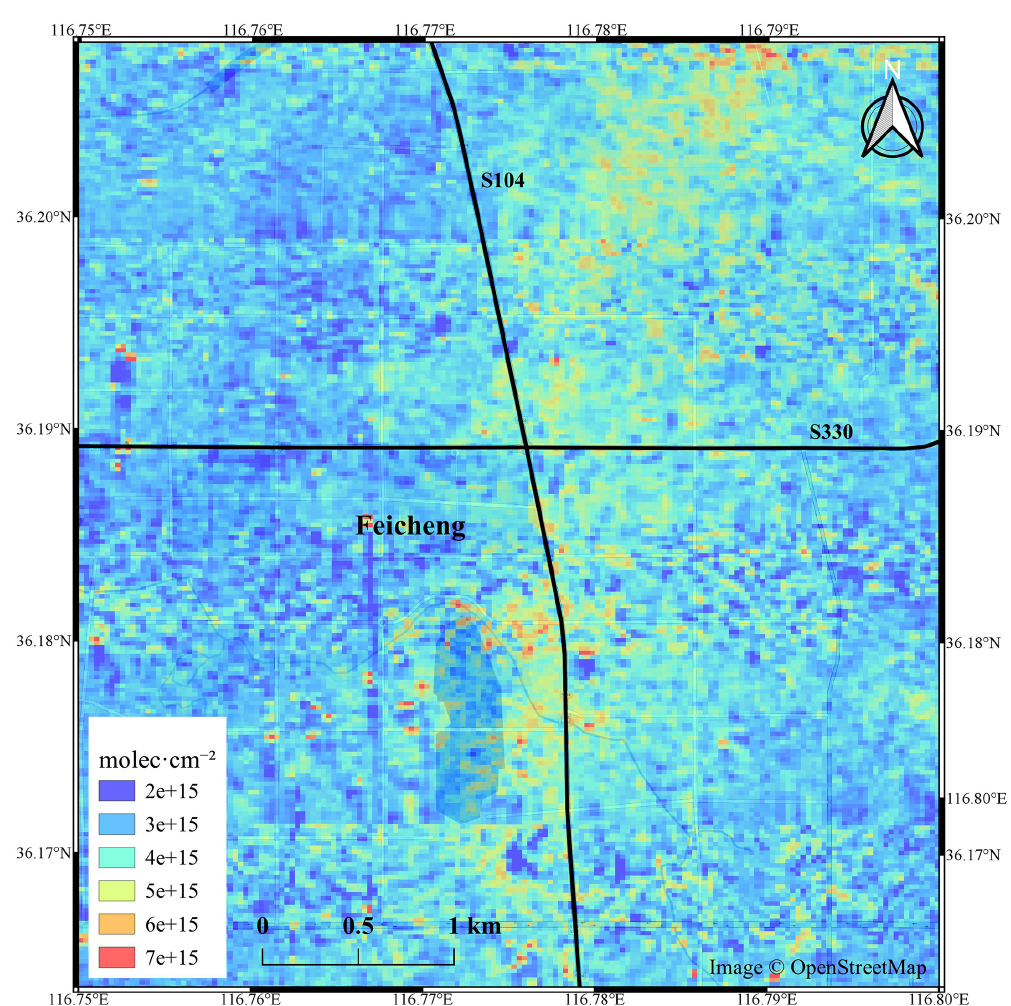
Figure 11. Enlargement of UVHIS NO 2 VCD map over Feicheng city with a colour scale only extends to 7 × 10 15 moleccm − 2 . Two black lines in the map represent two truck roads that cross Feicheng city: S104 and S330. © OpenStreetMap contributors 2021. Distributed under a Creative Commons BY-SA License.